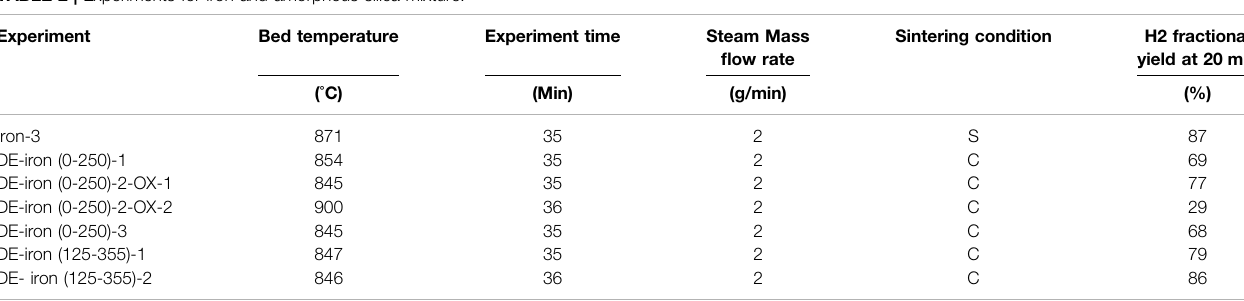
TABLE 2 | Experiments for iron and amorphous silica